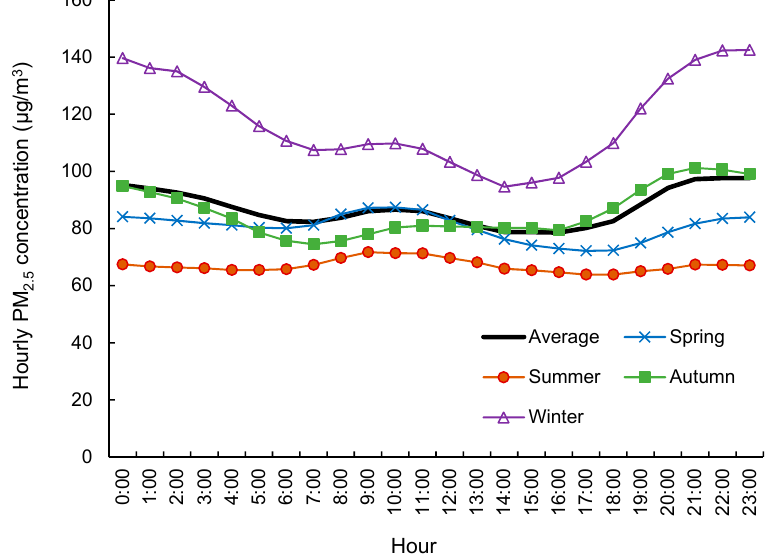
Figure 3. Diurnal change of PM 2.5 in different seasons.